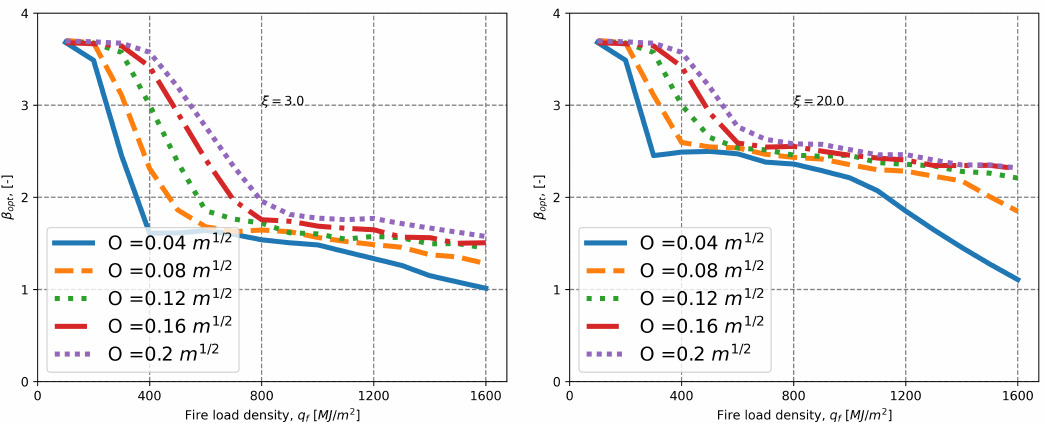
Figure 5. Reliability targets for steel column for parametric fire exposure of steel column (constant annual fire probability of 2 . 5 × 10 − 3 and, two cases of relative failure costs, ξ = 3 . 0 and 20 . 0